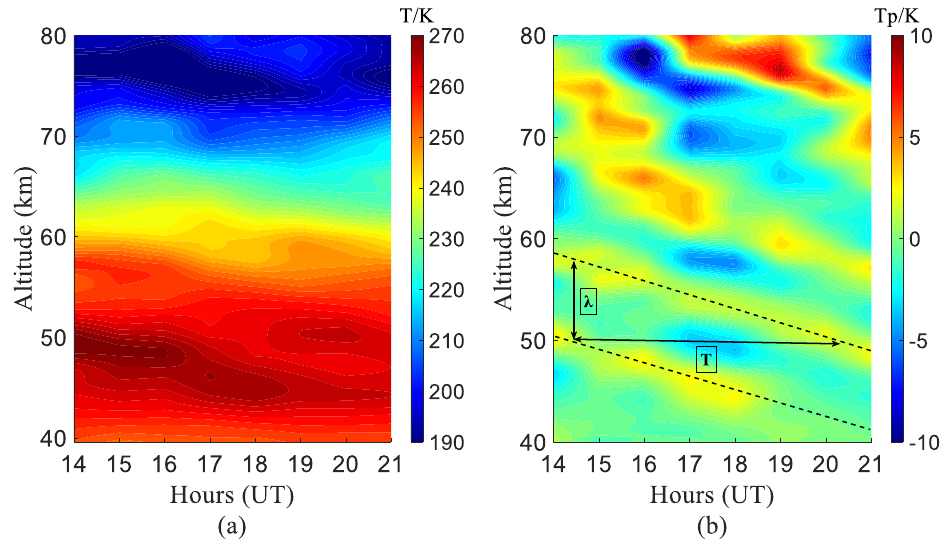
Figure 1. The temperature ( a ) and temperature perturbations ( b ) on 10 May 2020. λ and T indicate the vertical wavelength and period of the wave, respectively.